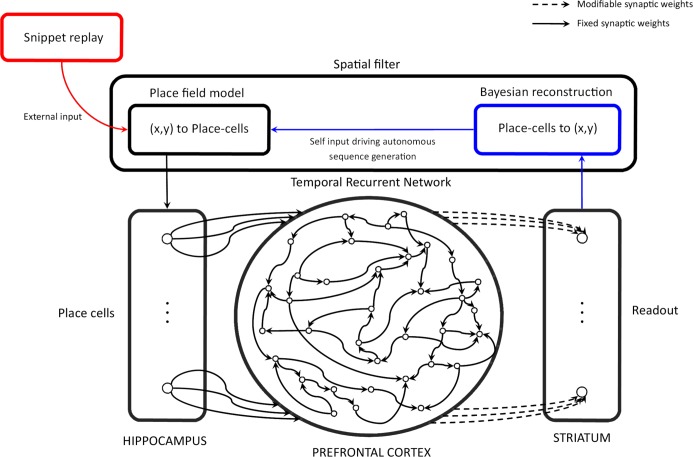
Reservoir computing model.The Temporal Recurrent Network (TRN) is a model of the prefrontal cortex (PFC) that takes into account cortico-cortical loops by defining a fixed recurrent adjacency matrix for the leaky integrator neurons that model PFC neurons. Inputs of the TRN are modelled hippocampus (HIPP) place-cells. During the training phase, place-cells activations are provided by the algorithmic model of SWR replay (red pathway), and the striatum model learns to predict the next place-cell activation from the PFC model states by modifying the synaptic weights that project the PFC model into the striatum model according to the delta learning rule. During the generation phase, the model is no longer learning and the place-cell activation patterns result from the new position of the agent, reconstructed with a Bayesian algorithm from the next place-cell activation prediction of the modeled striatum (blue pathway).